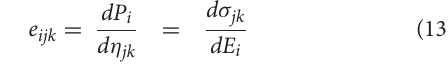
Frontiers in Physics |